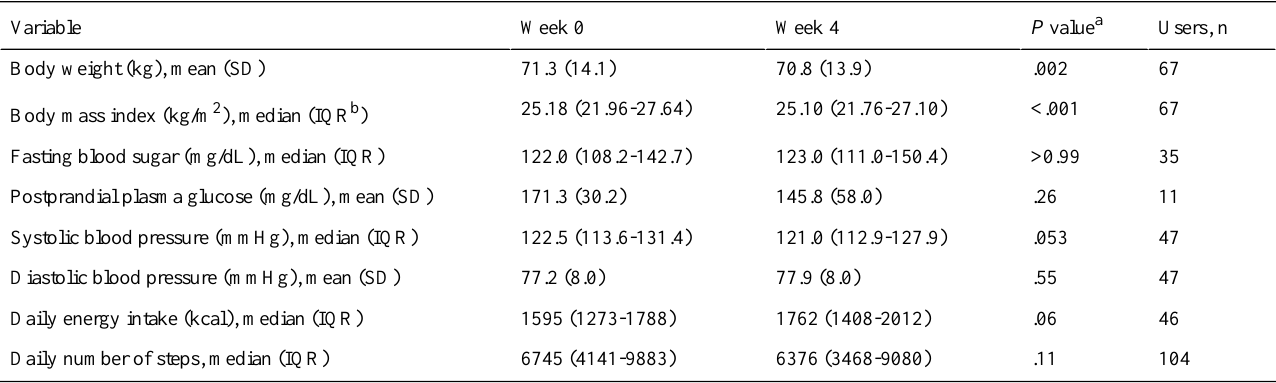
Table 5. Comparison of robust users’data between weeks 0 and 4.